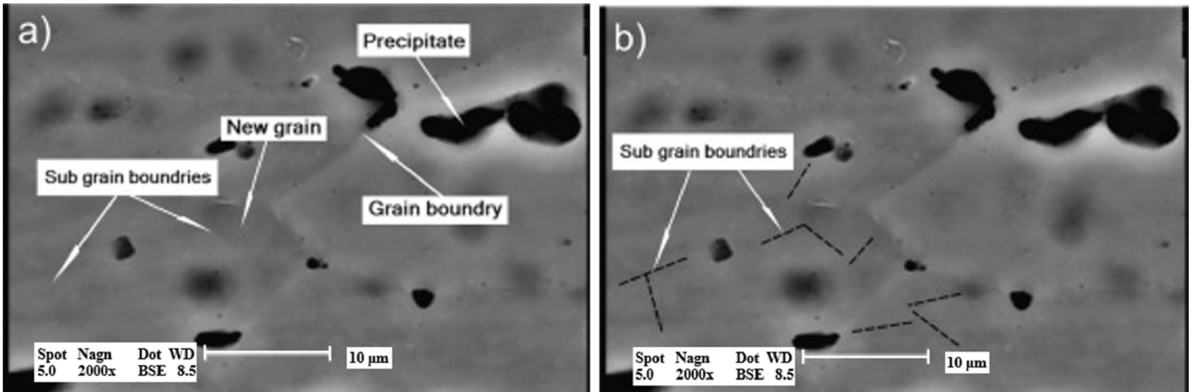
Figure 7. Schematic diagram of SEM graphs for the post-processed surface. ( a ) original image and ( b ) marked subgrain. (Reprinted with permission from ref. [103]. Copyright 2016